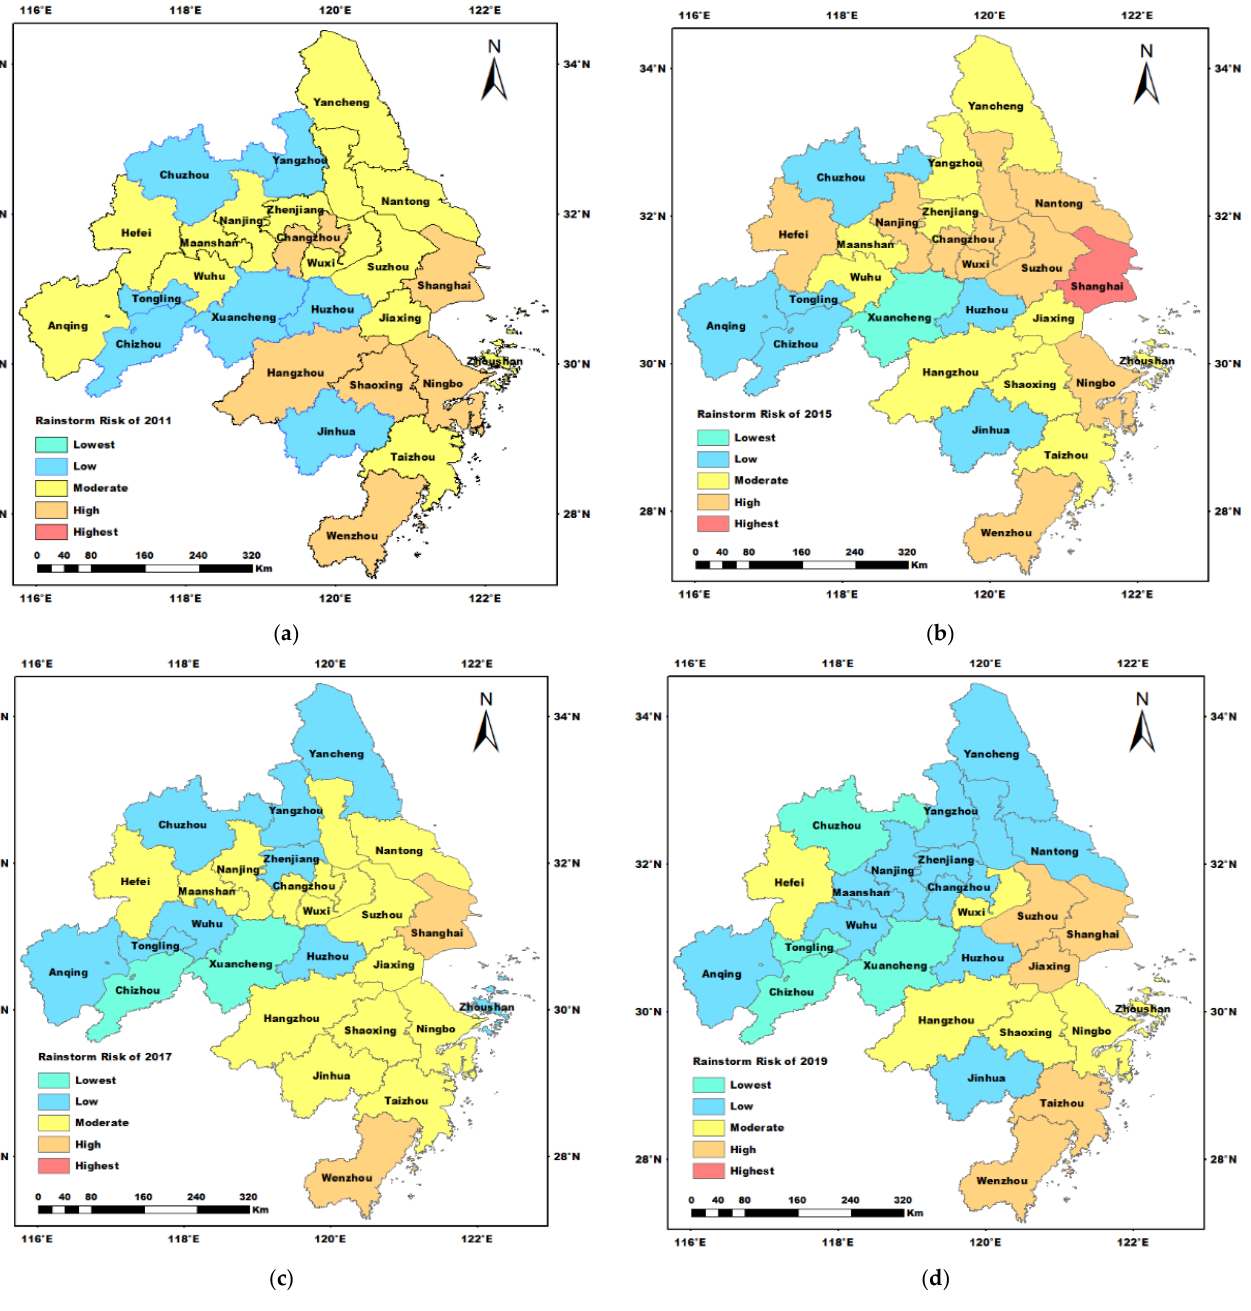
Figure 5. The spatio-temporal distribution of rainstorm disaster risk level of 27 cities from 2011 to 2019 ( a ) the rainstorm disaster risk of 2011; ( b ) the rainstorm disaster risk of 2015; ( c ) the rainstorm disaster risk of 2017; ( d ) the rainstorm disaster risk of 2019. Due to the space constraints, and for a better illustration, we only provided the rain- storm disaster risk in the years 2011, 2015, 2017, and 2019. As is shown in Figure 5, the rainstorm disaster risk levels in the eastern and southern regions are higher than that in the western and northern regions, respectively. The lower rainstorm disaster risk cities are mainly in the central and northwest of the Yangtze River Delta. For example, due to the low frequency and less amount of precipitation, the rainstorm disaster risk of Huzhou is relatively lower than the risk of other cities. The cities in the northwest have lower rain- storm disaster risk, mainly due to the low density of the river network and population, the higher elevation, and the relatively less developed economy. The eastern coastal and southeastern areas with concentrated populations and developed economies have higher rainstorm disaster risk, such as Shanghai, Hangzhou, Ningbo, etc. Meanwhile, due to the high level of social and economic development, the cities in the Yangtze River Delta gen- erally have good disaster prevention and reduction ability. Generally, the areas with high economy developed have higher disaster prevention and reduction ability. As is shown in Figure 5, the rainstorm risk level increased in Shanghai during 2011–2015 and decreased in the period 2017–2019. The geological and climatic conditions mean that Shanghai is prone to suffer rainstorm disasters. From 2011 to 2017, the rainstorm disaster risk demon- strates an upward trend [49]. The hard and soft protection strategies can reduce the rain- storm risk effectively [47]. Meanwhile, due to the geographical location and climatic con- ditions, the rainstorm risk level of Wenzhou is high throughout the studied periods. Ac- cording to the previous study, Wenzhou is located on the southeast coast of China, which is prone to typhoons and faces the highest risk of rainstorm disasters [50]. To further ex- plain and discuss the spatiotemporal distribution of rainstorm risk levels, the percentage of rainstorm risk classes during the five reference years is shown in Table 2.